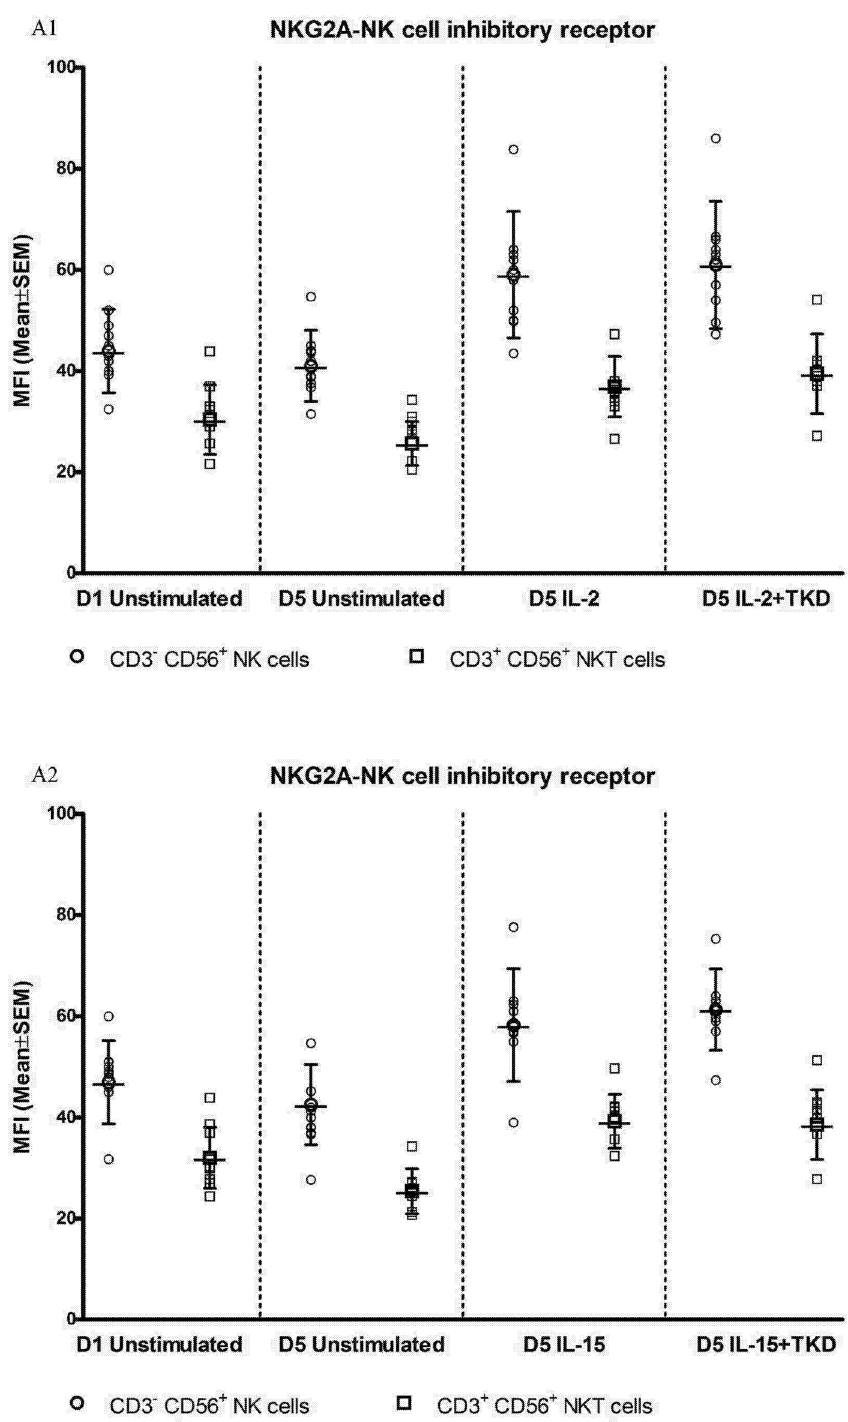
Fig 18. The effect of IL-2, IL-15, IL-2/TKD and IL-15/TKD on the expression of NKG2A in peripheral blood mononuclear cells of healthy individuals — the amount of receptor expressed by CD3 - CD56 + NK cells and CD3 + CD56 + NKT cells (the median fluorescence intensity). The amount of NKG2A expressed by CD3 - CD56 + NK cells and CD3 + CD56 + NKT cells was examined within the fraction of unstimulated and stimulated mononuclear cells derived from 10 healthy individuals. Data are presented as means ± standard error. In total, the study cohort consisted of 52 Caucasian healthy individuals.